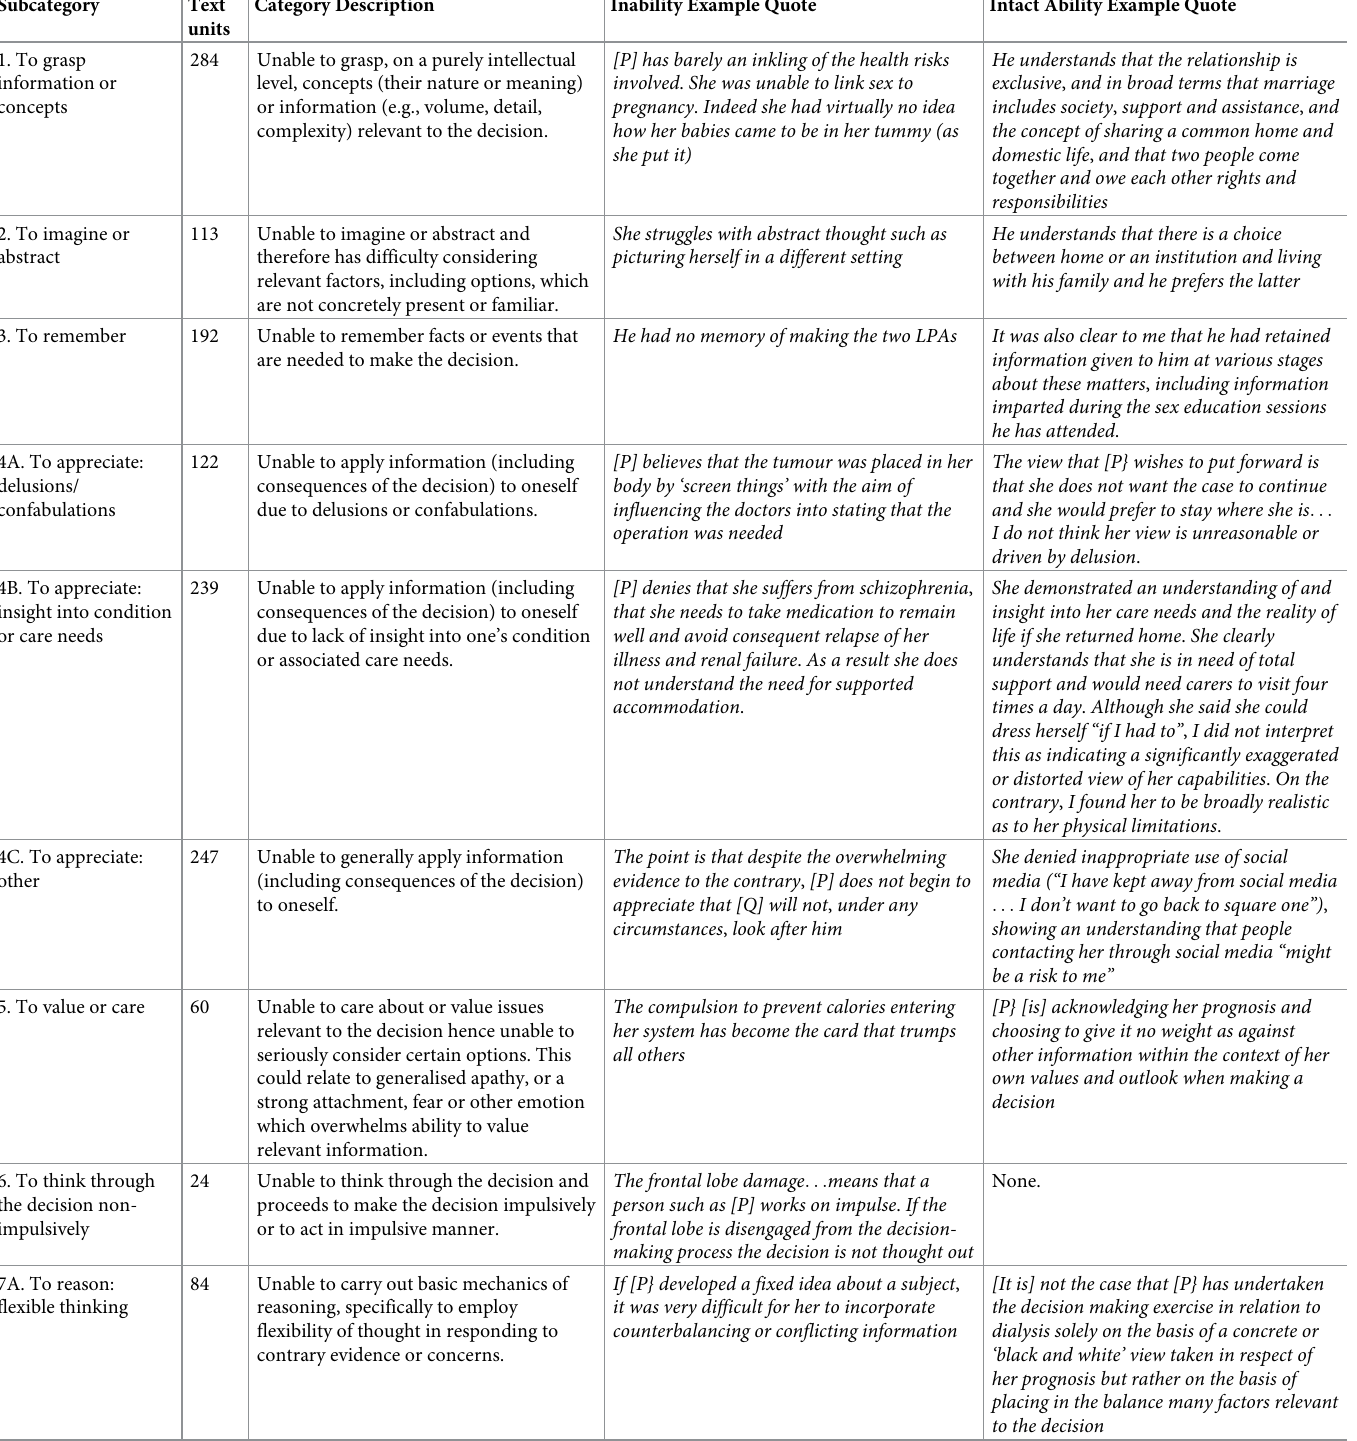
Table 2. Typology of capacity rationales 1,2